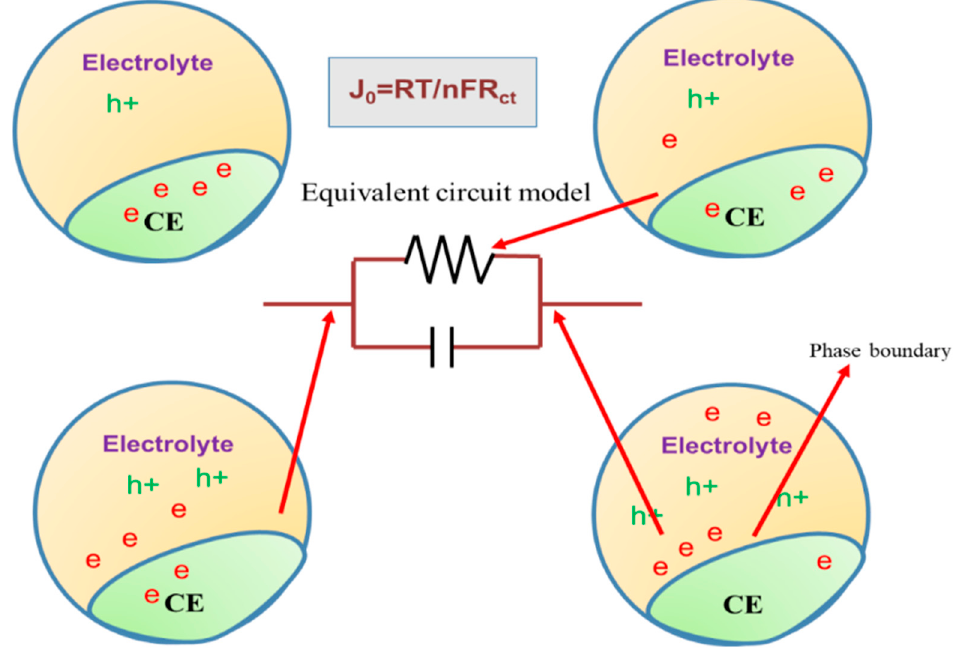
Figure 4. Schematic diagram of the reaction site at the counter electrode (CE)/electrolyte interface region and the electron transfer mechanism from the CE to the electrolyte material.